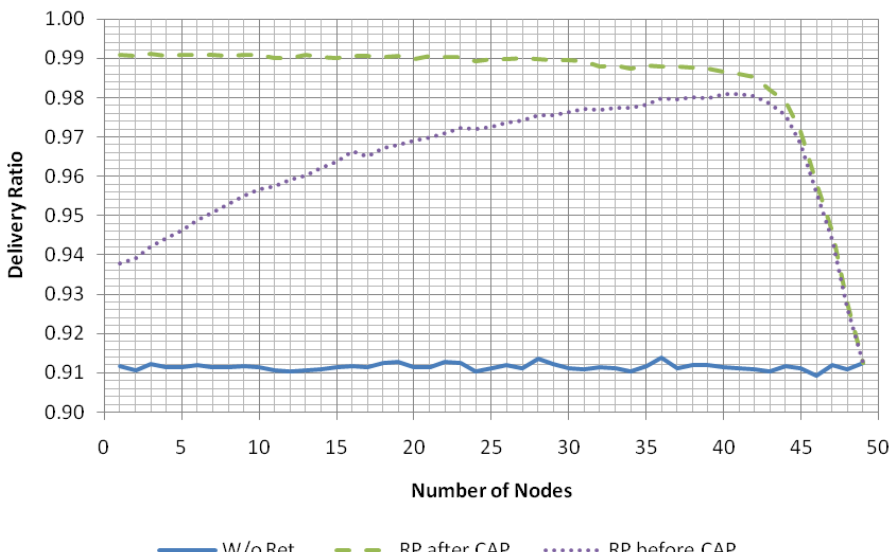
Figure 8. Delivery ratio of eLPRT with BER